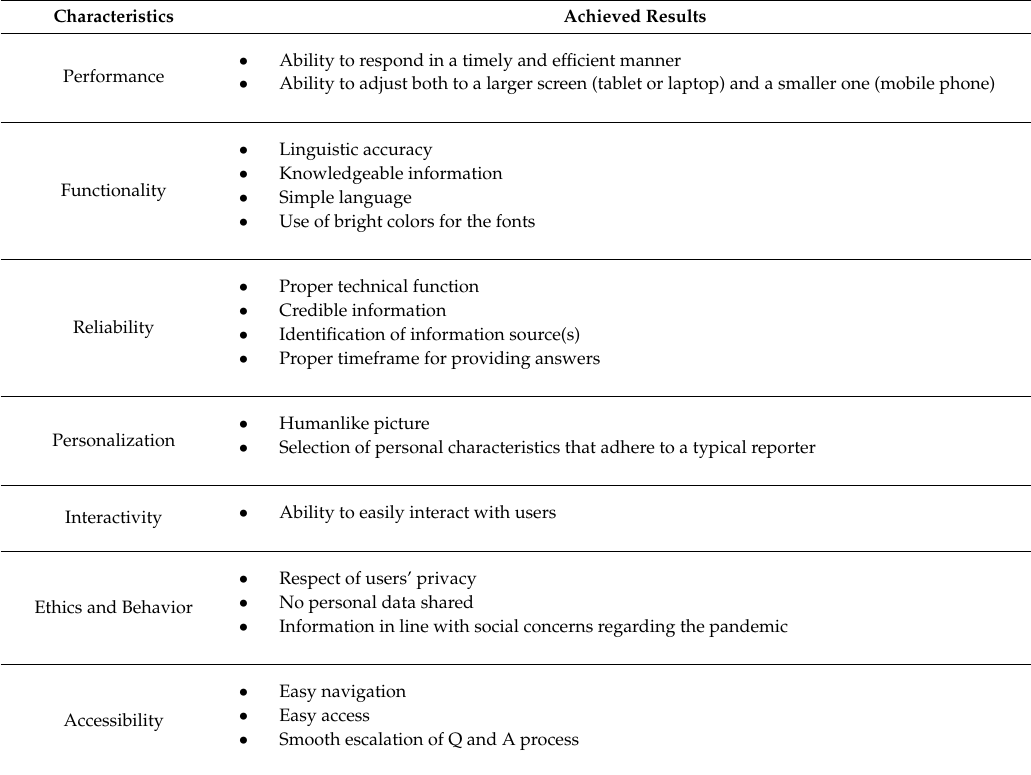
Table 1. Expected characteristics and achieved